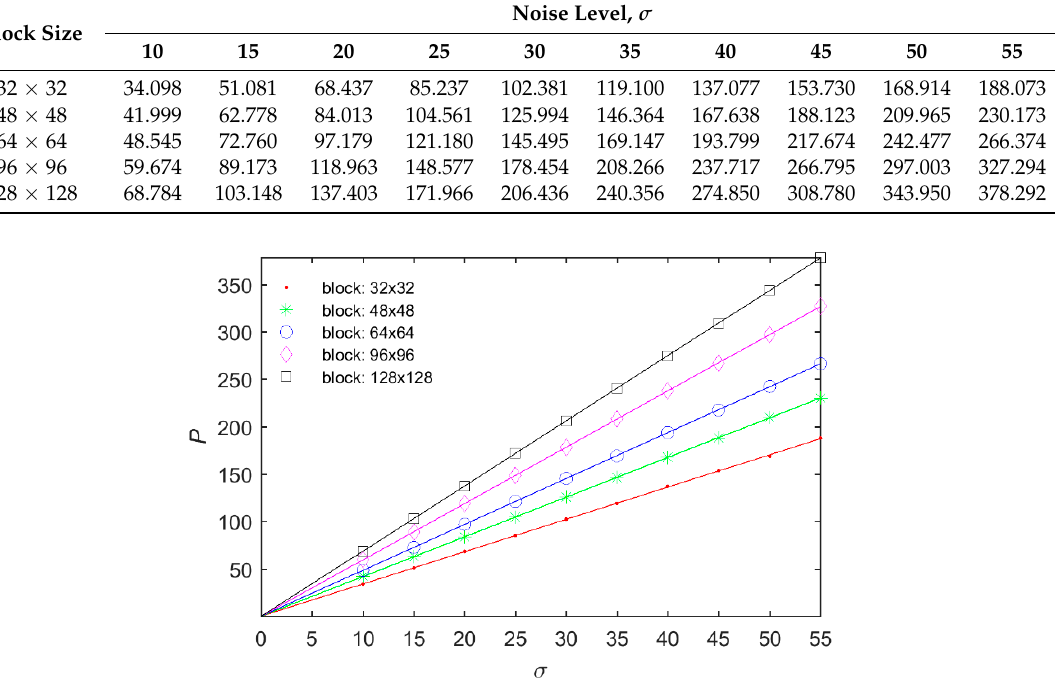
Figure 3. The average P ( M ) values across a range of noise levels and the associated results of the least square fitting.